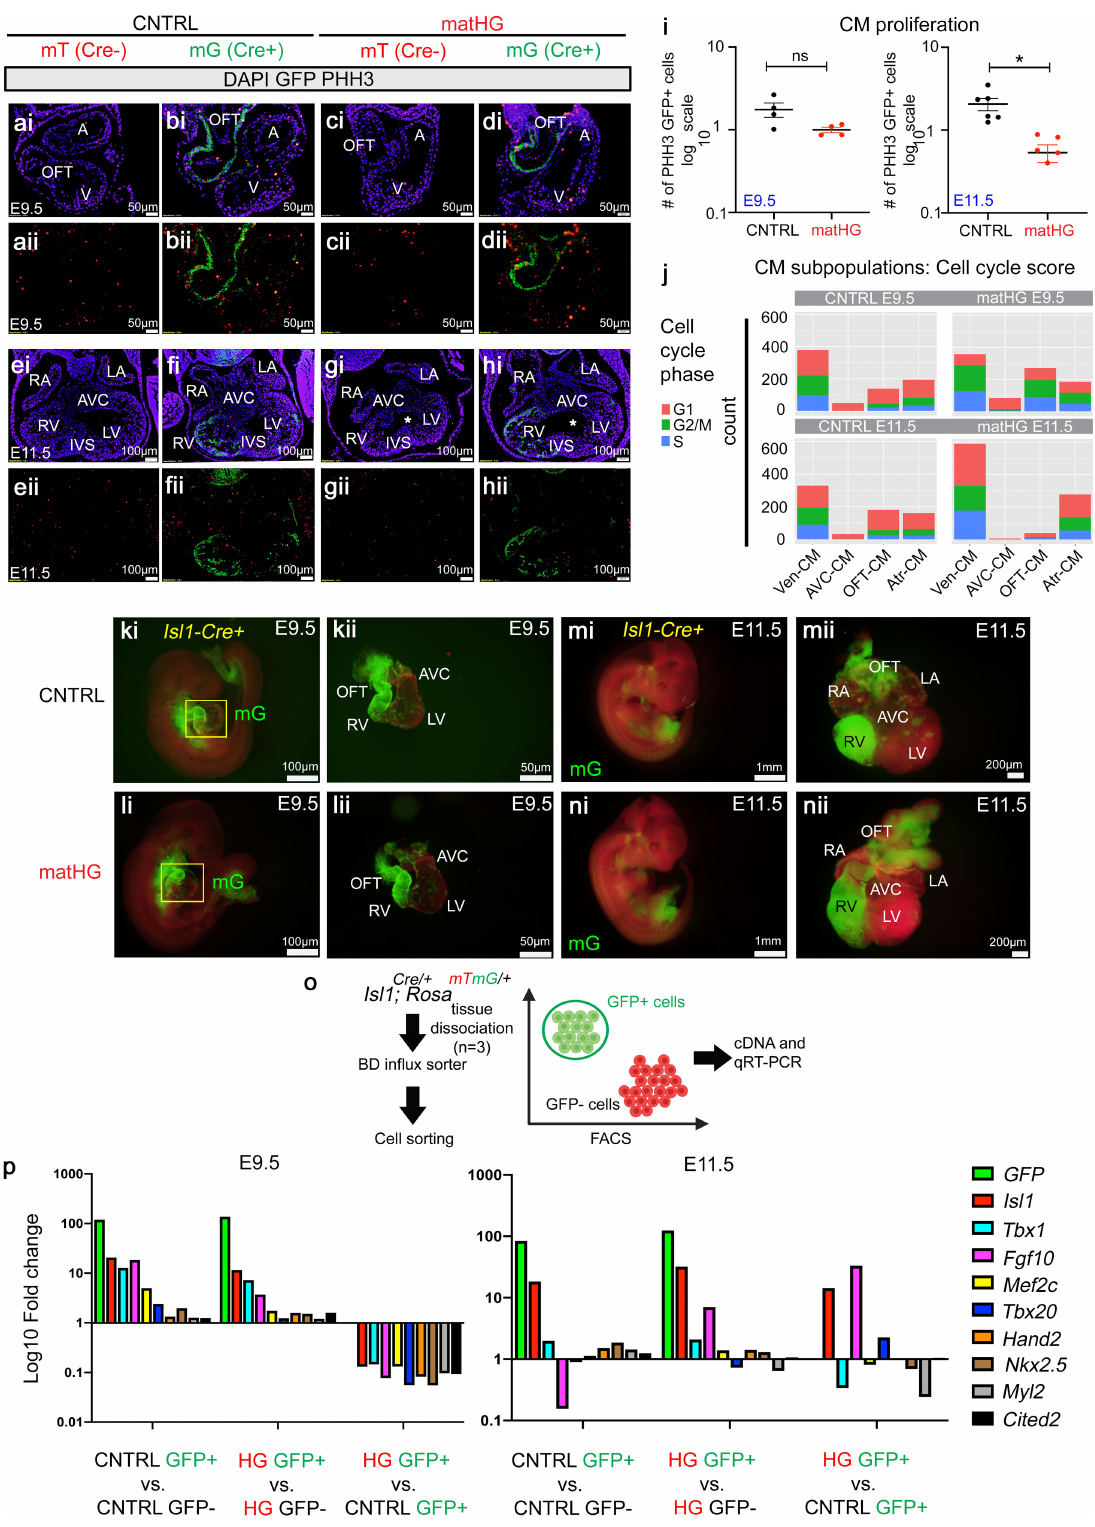
and Tnnt2 + CM populations subjected to intrauterine matHG have signi fi cant differences in gene expression compared to other cell types identi fi ed in scRNA-seq. The CM is the fundamental work unit of the heart. Although CM fate is a developmental end point, a diversity of CM subtypes exists within the heart 83 . After ballooning morphogenesis, the expansion of chamber-speci fi c CM is followed by delamination and trabeculation, which